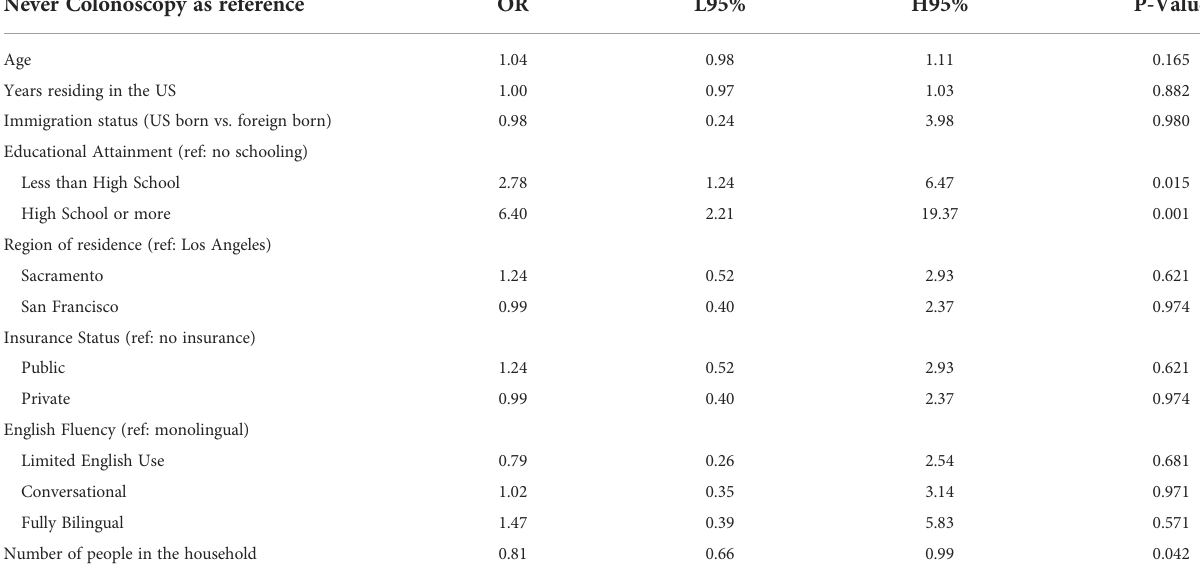
TABLE 6 Multivariate logistic regression model testing the association between colorectal screening behavior and demographic factors among ‘ Tu Historia Cuenta ’ participants ages 50+ (N=240, 24 excluded from 264 due to missing data). Never Colonoscopy as reference OR L95%